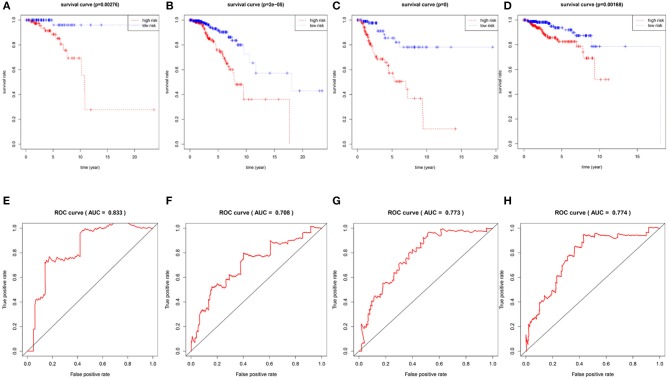
Verification the specificity and sensitivity of the 7-lncRNA prognostic model. The Kaplan-Meier curve of patients with stage I, stage II, stage III, and Her2-positive BRCA (A–D); the ROC curve of the model at 3 years of OS with stage I, stage II, stage III, and Her2-positive BRCA, the AUC values were 0.883, 0.708, 0.773, 0.774 (E–H).